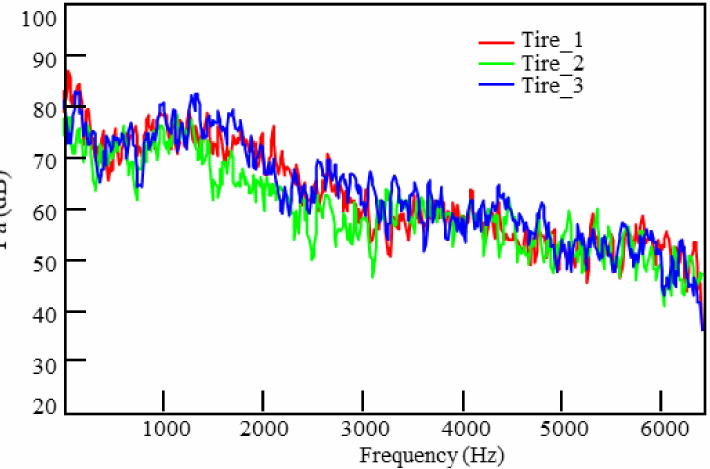
Figure 15. Frequency spectra of excitations of the left front tire under the 50 km/h working